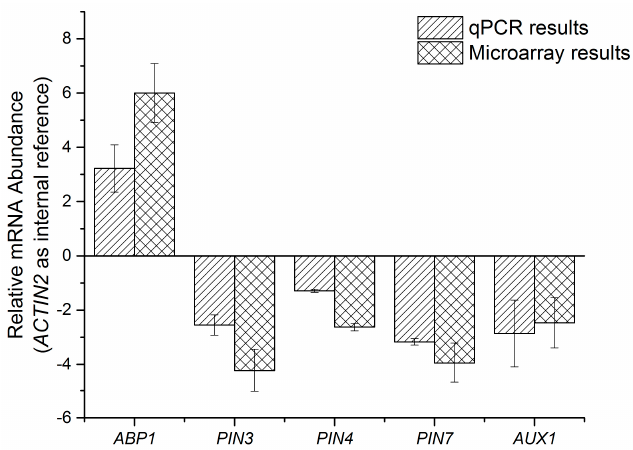
Figure 2. Relative expression of auxin-metabolism related genes. For both qPCR and microarray analysis, plants grown at 23 °C were collected as control group, and plants grown at 37 °C were collected as HS group. ACTIN2 was used as an internal reference for both assays.